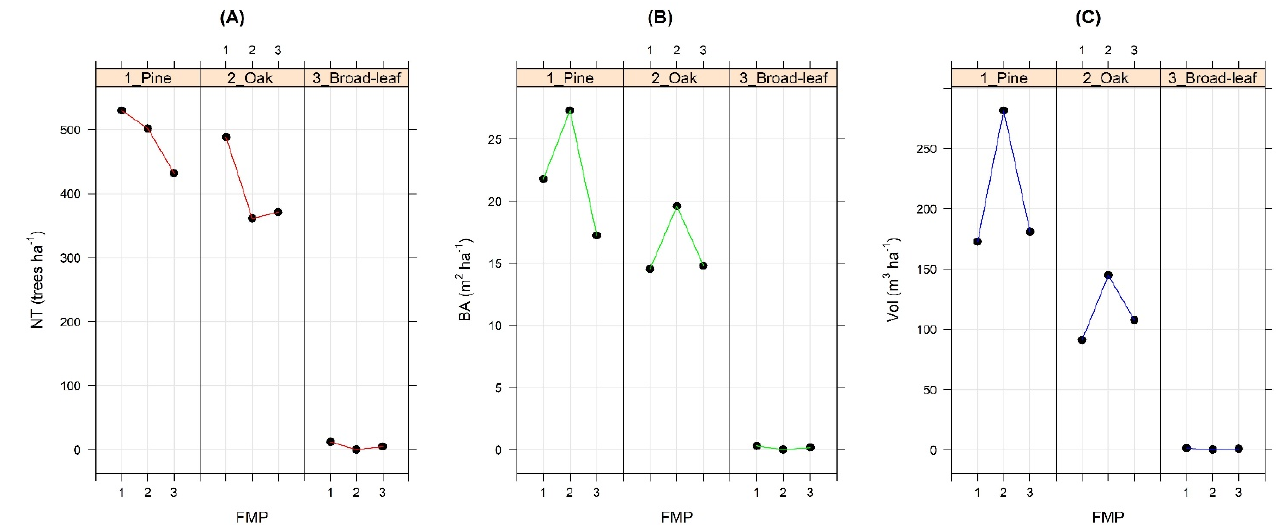
Figure 3. Comparison of the number of trees ( NT ) ( A ), basal area ( BA ) ( B ), and volume ( Vol ) ( C ) under the three forest management plans (FMPs) in the A0208 sub-stand.